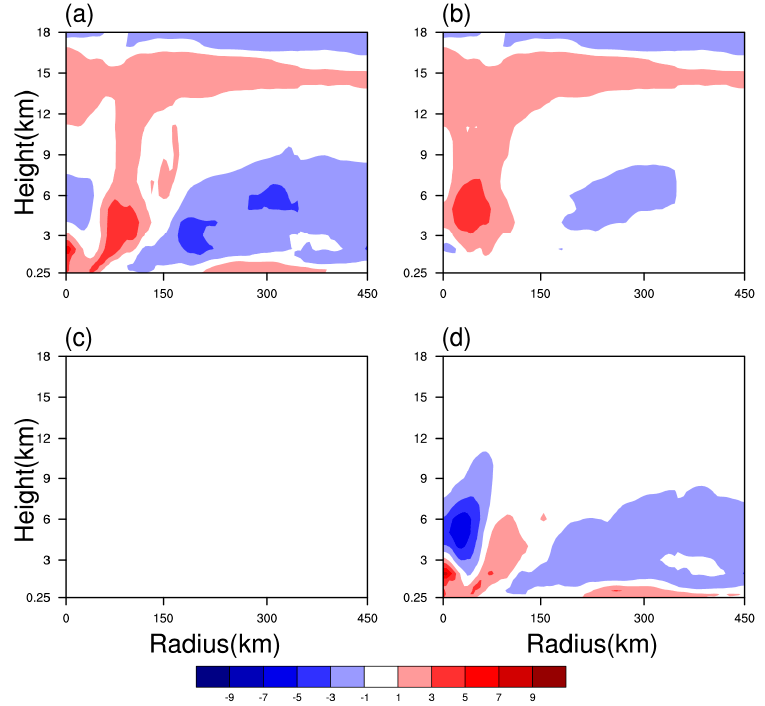
Figure 5. Height-radial cross-sections of the change of ( a ) MSE, ( b ) C p T , ( c ) gz , and ( d ) L v q from hour 48 to hour 72 (units: 10 3 J).